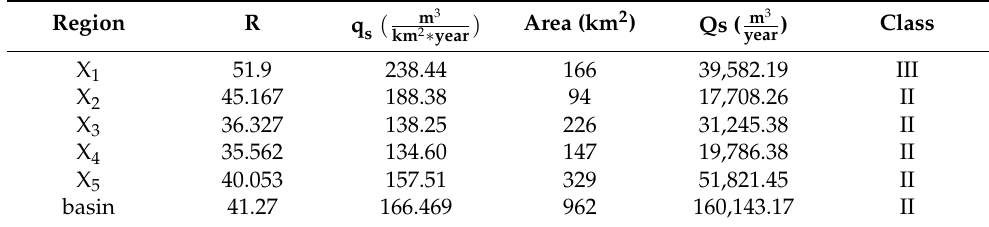
Table 6. Amount of sediment yield and classification of sub-basins of the Babolroud basin.